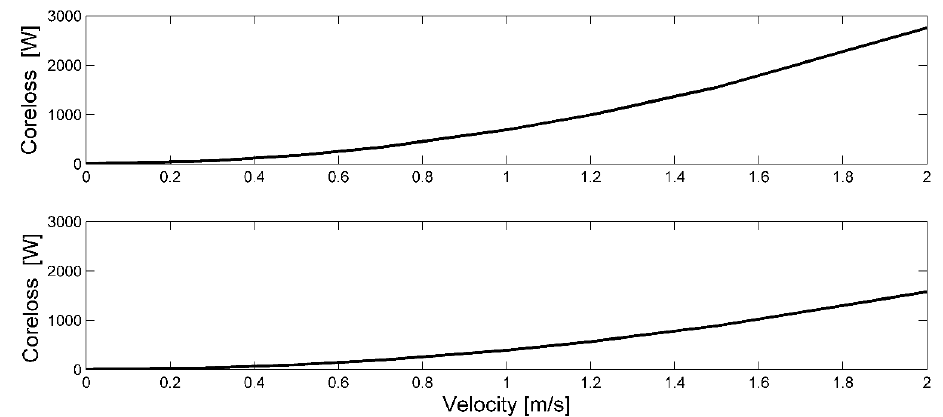
Figure 8. The core loss in the translator at di ff erent velocities’ during upper graph) Interval I and lower graph) Interval II.